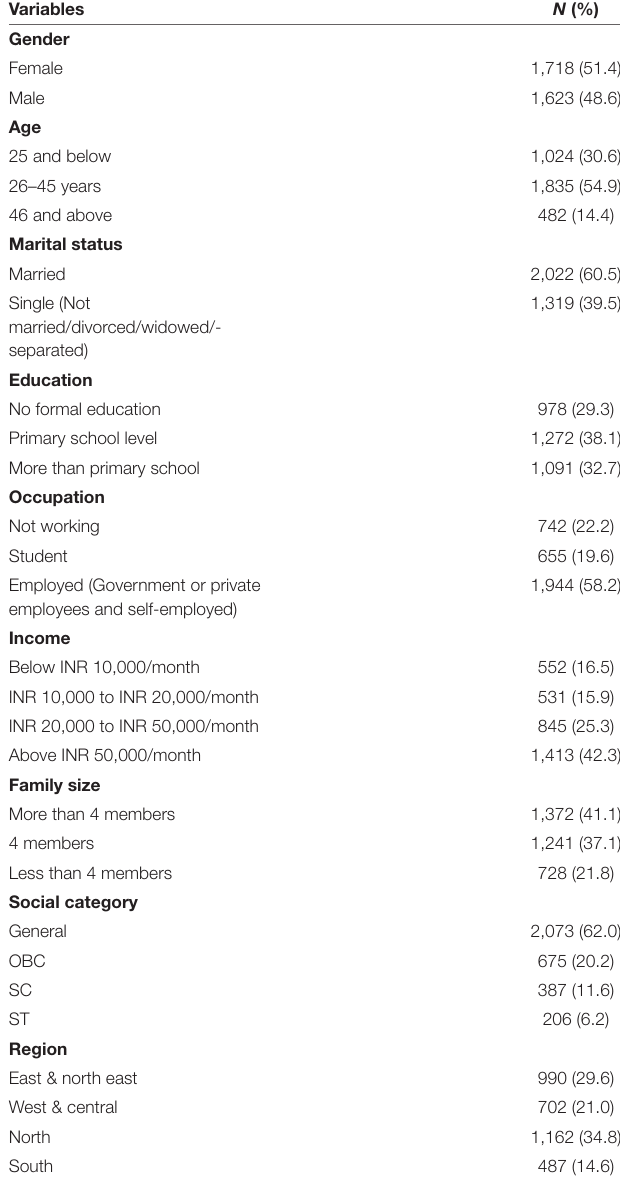
TABLE 1 | Description of socio-demographic factors for willingness to